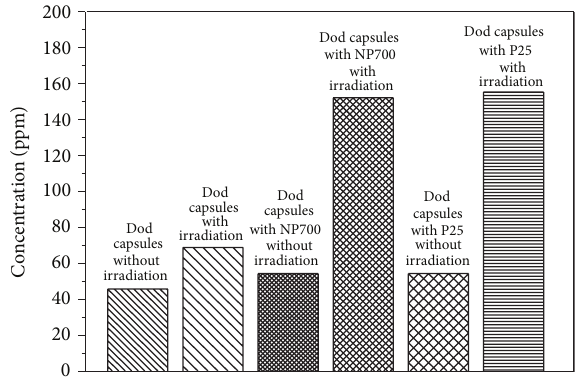
Figure 11: Concentration (ppm) of the output release of dodecane (Dod) from the polyamide microcapsules, for different samples and experimental